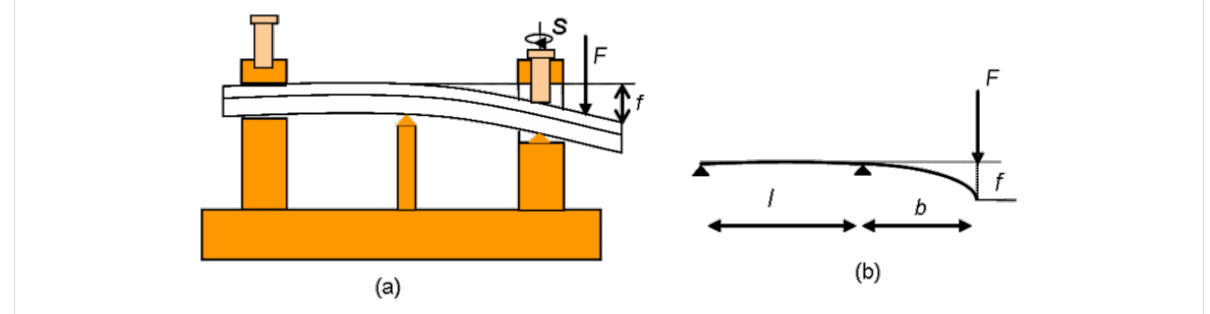
Figure 2: (a) Sketch of the setup used for bending tests; F represents the force produced by the screw S used to apply the bending stress and f is the vertical displacement of the sample surface from the horizontal position. (b) Schematic view of the geometry of the sample under test. The sample dimensions are: 150 × 20 × 3 mm.